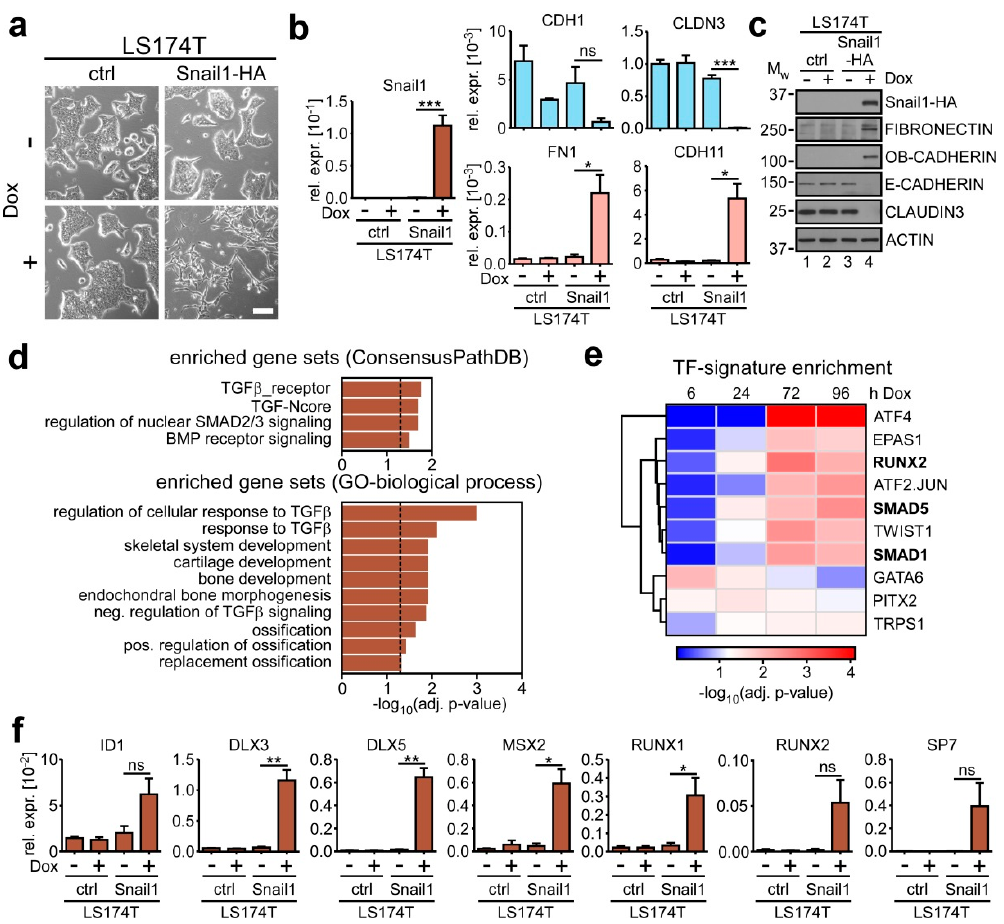
Figure 1. SNAIL1 induces bone morphogenetic protein (BMP) target genes during epithelial- mesenchymal transition (EMT) in colorectal cancer cells. ( a ) Representative phase contrast images of LS174T-ctrl and LS174T-Snail1-HA cells. Cells were left uninduced or were treated with 0.1 µ g · mL − 1 Dox for 72 h. Scale bar: 100 µ m. ( b ) qRT-PCR analyses of mRNA expression in LS174T-ctrl and LS174T-Snail1-HA cells. Where indicated, cells were treated with 0.1 µ g · mL − 1 Dox for 72 h. Shown is the mean + SEM; n = 3. Rel. expr.: relative expression normalized to that of GAPDH . ns: not significant. *: p < 0.05, ***: p < 0.001. ( c ) Western blot analyses of whole-cell lysates. Names of detected proteins